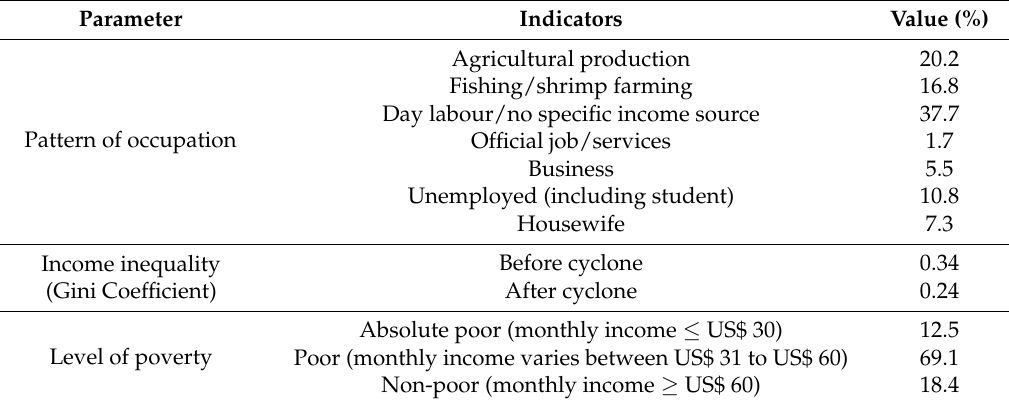
Table 3. Occupational pattern and economic capacity of the